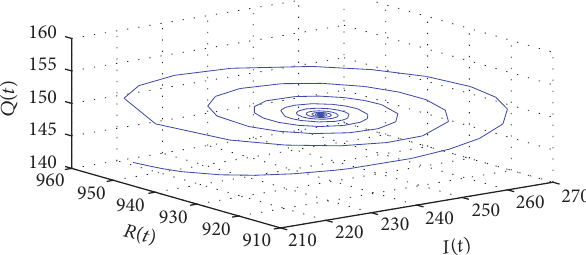
= 2.862 and 𝜏 = 2.45 ∈ (0,𝜏 ) 2 1 10